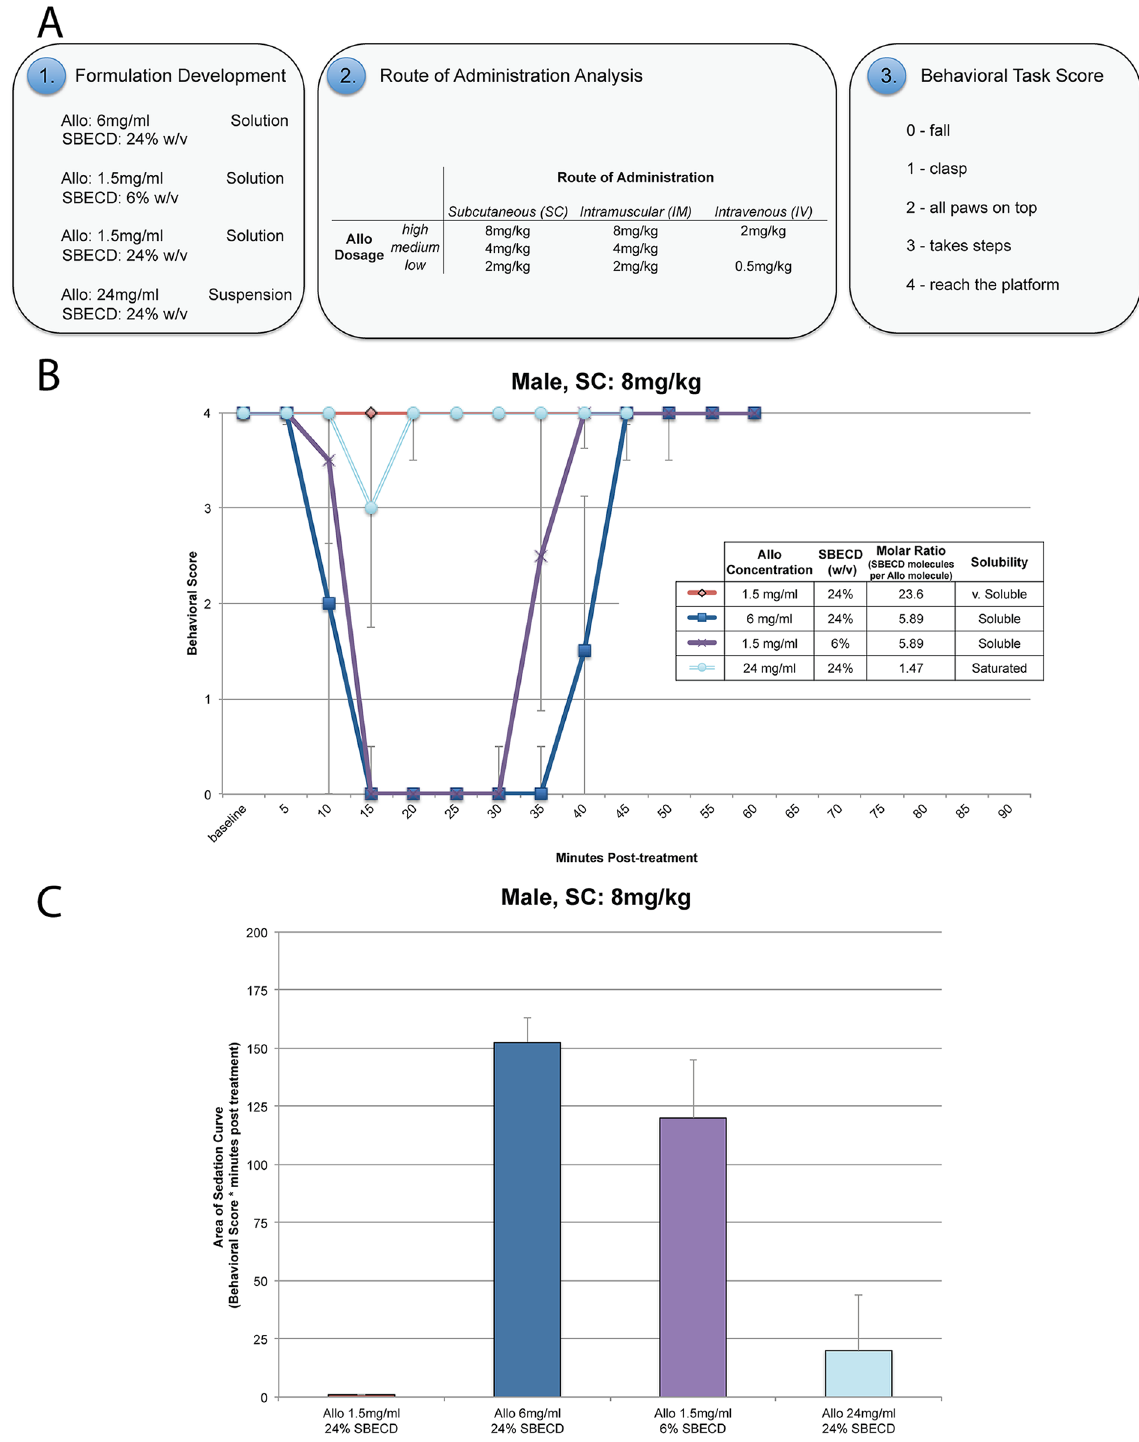
Fig 4. Formulation development, route of administration, and rat behavioral task study components. Study design. A. Four different formulations were administered by subcutaneous (SC) route to male rats at the maximally tolerated dose (MTD) for sedation, determined to be 8 mg/kg for the leading formulation Allo 6 mg/ml, 24% sulfobutyl-ether- β -cyclodextrin sodium (SBECD). Optimal release rate formulations for SC were then tested via dose-response for SC, intramuscular (IM), and intravenous (IV) routes using the rat balance beam behavioral task to score motor incoordination due to Allo-induced sedation, a biomarker of Allo target engagement and tolerability. Sedation score as a biomarker of Allo target engagement. B. The sedative component of GABA A receptor activation in the brain was used as a biomarker outcome of Allo delivery and tolerability. Male rats (Age 7 months at study initiation) were dosed by SC route of administration with multiple formulations, to determine effect on sedation. Doses were administered at Allo 8 mg/kg SC to compare